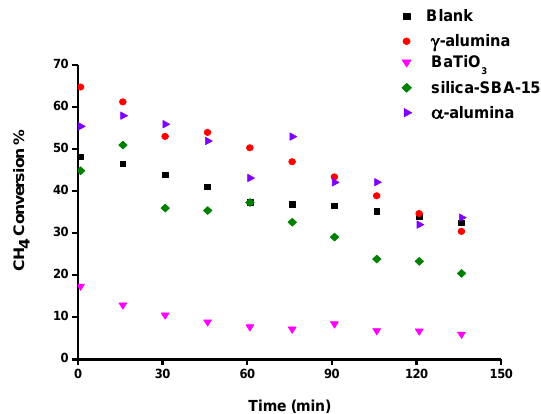
Figure 2. Conversion of methane as a function of time for different packing materials.